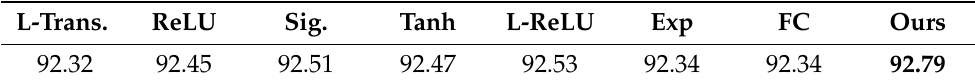
Table 5. Ablation study on polynomial in PSConv layer. We report shape classification accuracy on ModelNet40 (OA in %). Sig. denotes Sigmoid operation, L-trans. is short for linear transform. Our design with polynomials achieves the best accuracy.